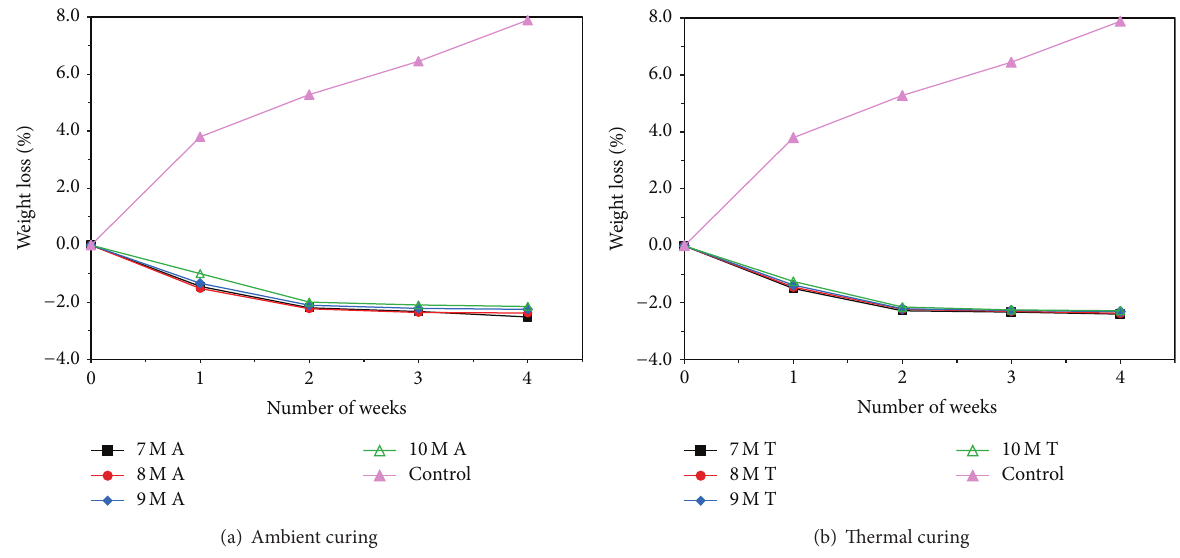
Figure 8: Weight loss for specimens immersed in 5% HCl after 28 days.